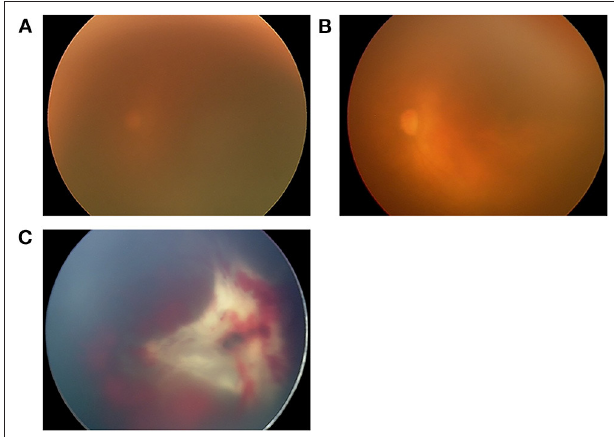
FIGURE 1 | Fundus images of the left eye of one patient in the V group (case 5), who received intravitreal ranibizumab monotherapy (IVR) for zone 1 plus retinopathy of prematurity. After receiving laser therapy for reactivation 7 weeks after IVR, vitreous hemorrhage occurred, and the fundus continued to be invisible for 4 weeks until absorption of the vitreous hemorrhage. (A) The fundus image obtained immediately before IVR demonstrated a blurred retina due to a prominent tunica vasculosa lentis. (B) Fundus image obtained 2 days after IVR showing improved transparency of the fundus and dilation of the retinal vessels. (C) Fundus image obtained 11 weeks after IVR showing volcano-shaped stage 5B ROP with thick proliferative membrane. This eye underwent LSV at 43 weeks postmenstrual age (PMA), and PPV and lensectomy for persistent retinal detachment at 44 weeks PMA, however, it was judged to be inoperable during